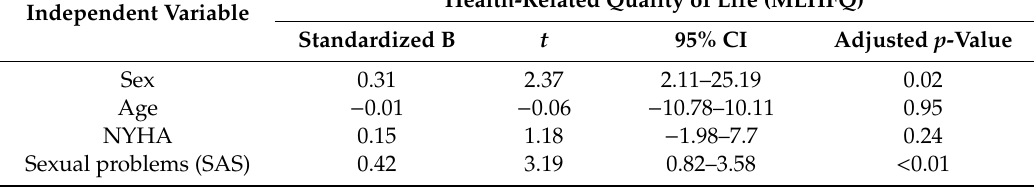
Table 4. Multiple linear regression with health-related quality of life (HRQoL) as a dependent outcome